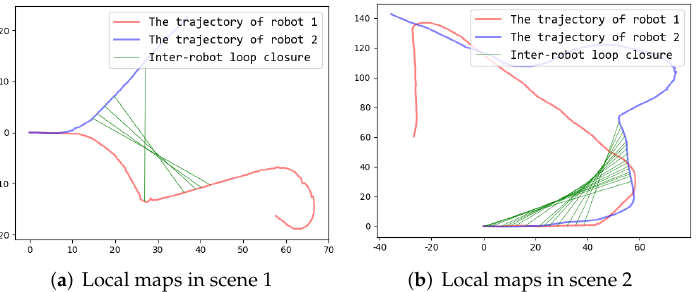
Figure 8. The local trajectories of robots in different scenes. The trajectories of robot 1 and robot 2 are shown in red and blue, respectively.